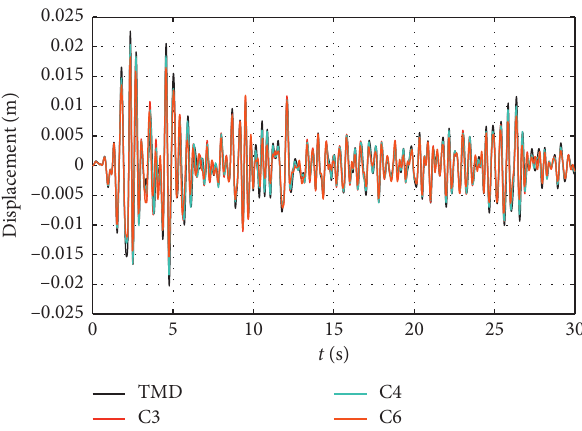
Figure 9: Generalized displacement when TMD mass ratio is 0.07 under the excitation of El Centro seismic wave. Table 1: Root mean square of generalized displacement with different TMD mass ratios and different structures installed, unit ( × 10 − 3 m). δ TMD